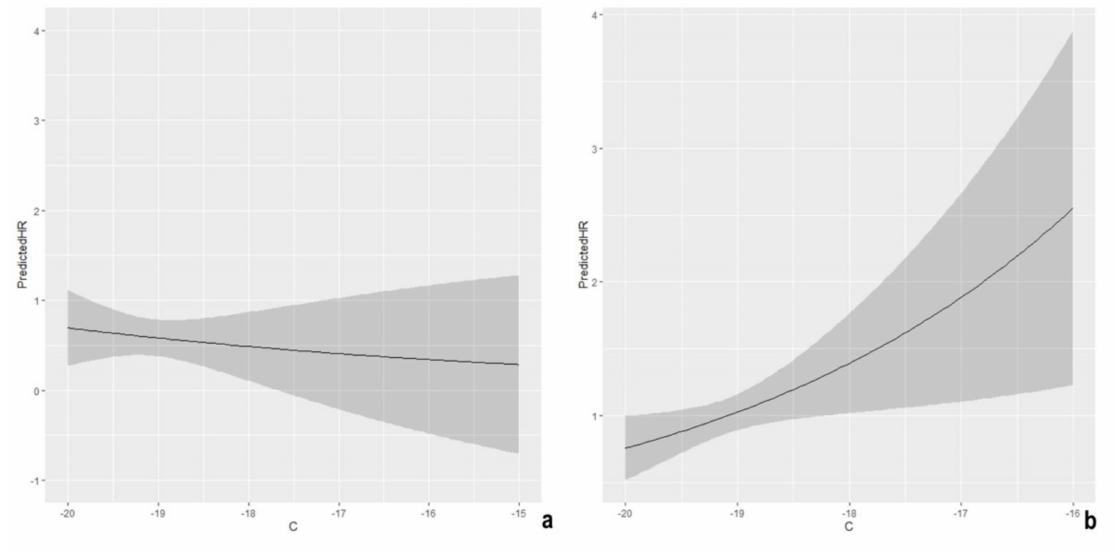
Figure 5. Shape of the predicted Hazard Ratio (HR) as a function of carbon isotopic signatures ( δ 13 C) in the Imperial Rome ( a ) and in the Middle Ages ( b ).